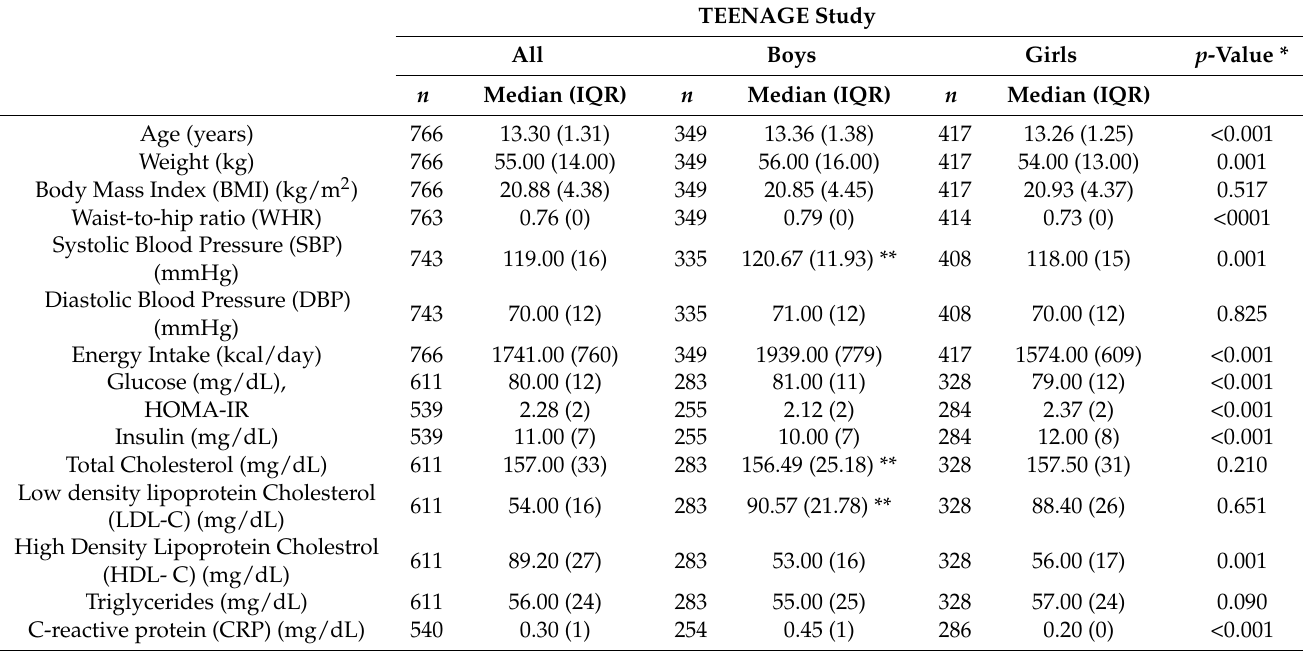
Table 1. Anthropometric, biochemical and dietary characteristics of the TEENAGE Study